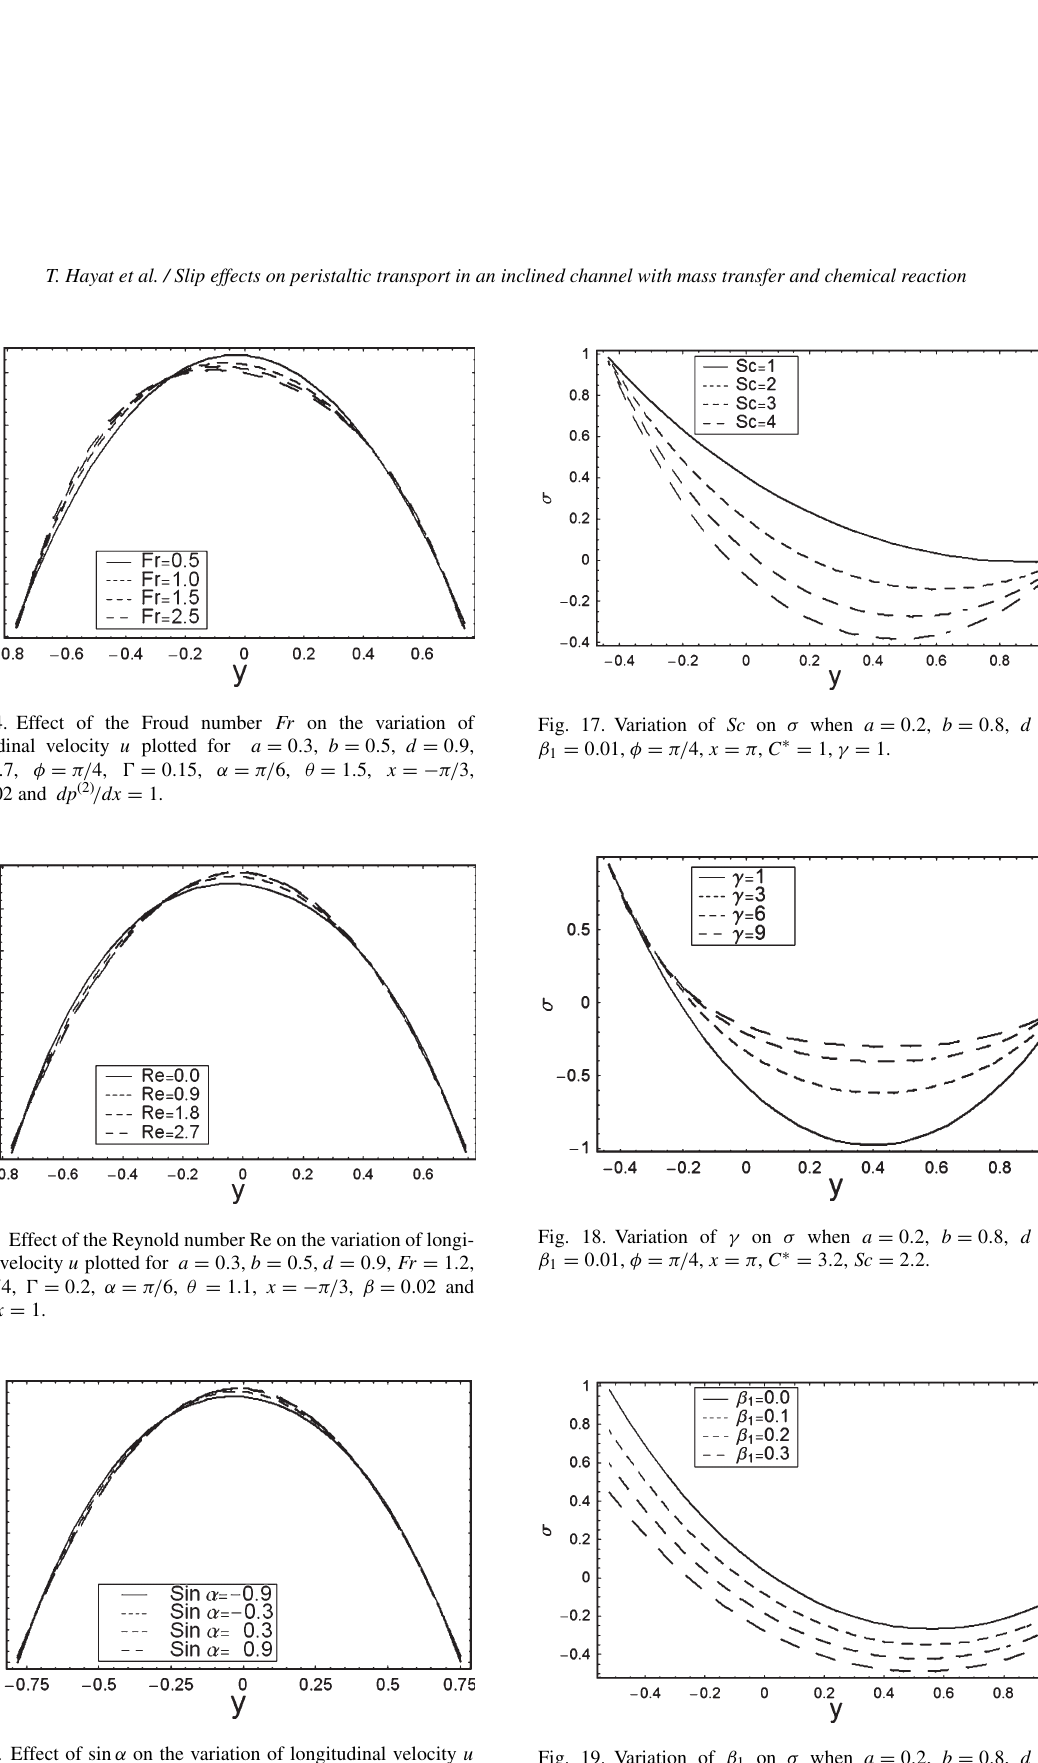
Fig. 19. Variation of β 1 on σ when a = 0 . 2, b = 0 . 8, d = 1, Sc = 1 . 5, φ = π/ 4, x = π , C ∗ = 1 . 5, γ =